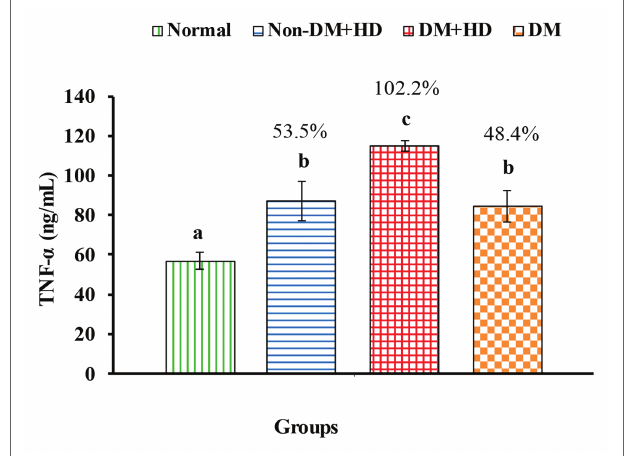
FIGURE 1 | The levels of tumor necrosis factor alpha [TNF- α (ng/mL)] in serum of non-diabetic and diabetic patients with or without kidney failure. Means, which have different superscript letters, are significantly different at p < 0.05. Percentage changes were calculated in comparison with normal group. Value of p :